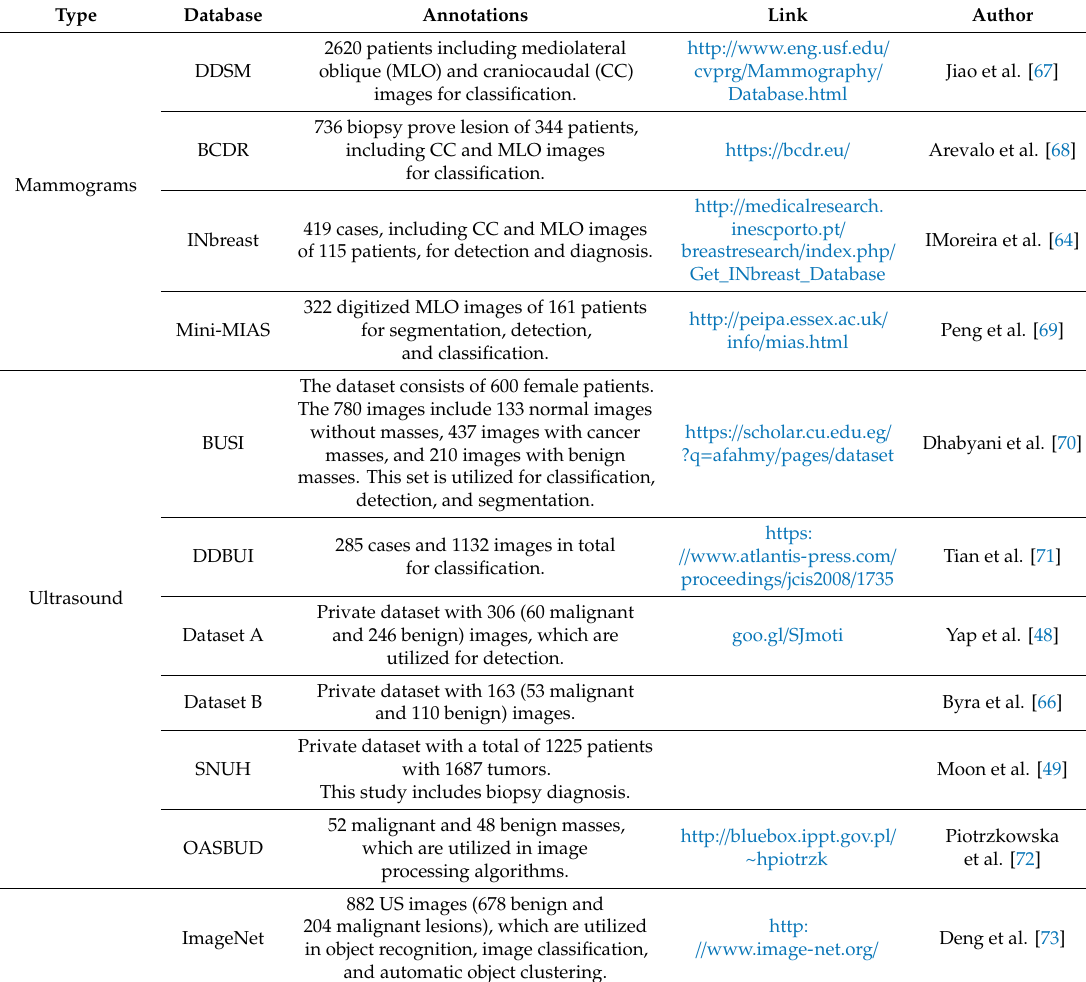
Table 1. Summary of the most commonly used public breast cancer databases in the